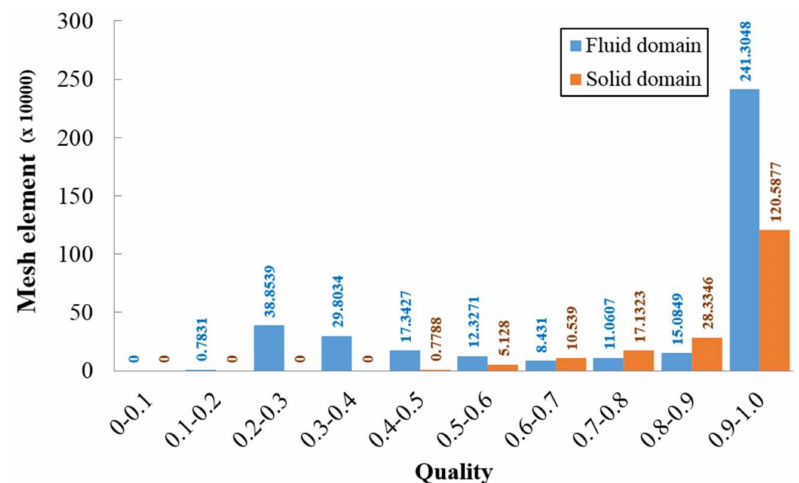
Figure 5. Mesh quality